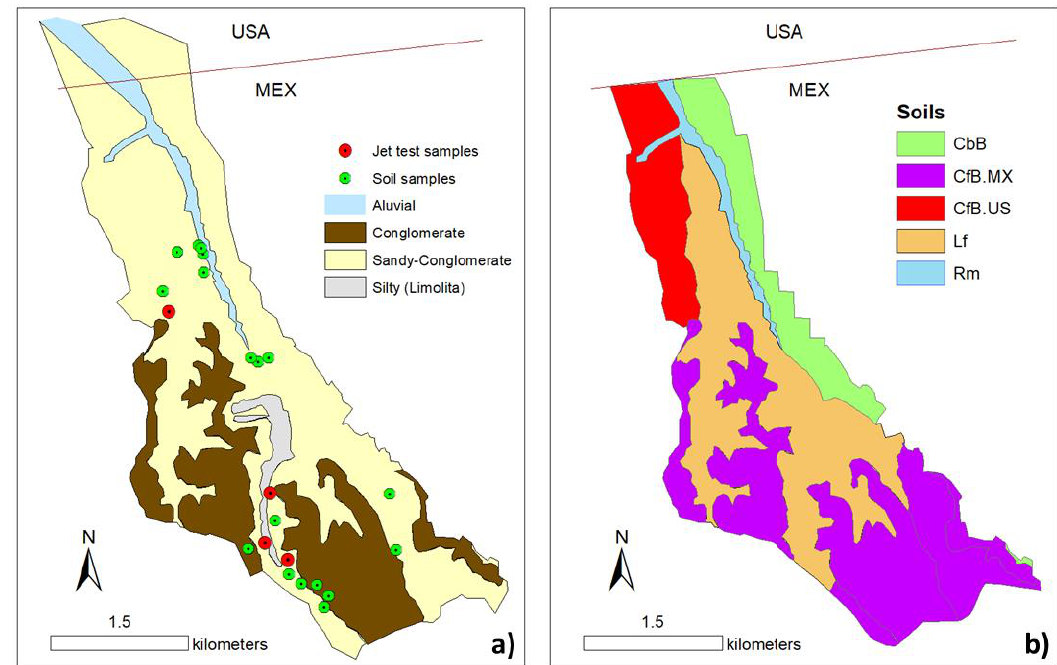
Figure 2. Ternary diagram of the mean grain sizes observed in the surface (SURF) and subsurface (SUB > 50 cm depth) soil layers for each soil type in the watershed, and in the sediment traps in Mexico (MXSB) and at the outlet in USA (USTRAP).